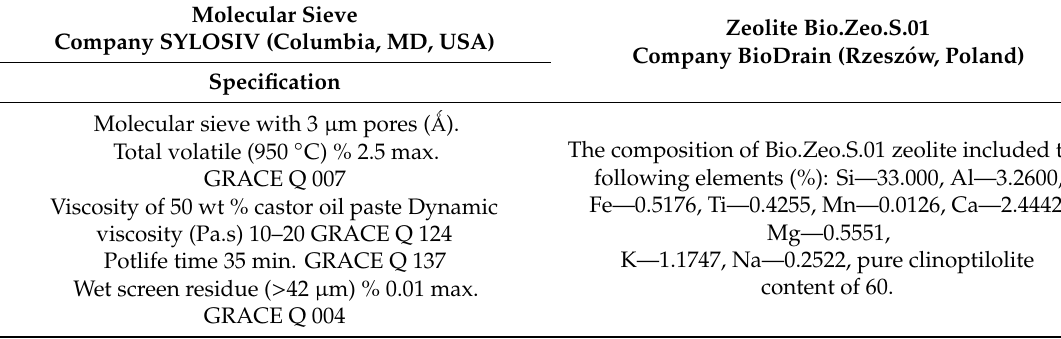
Table 2. Characteristics of the sorbents.